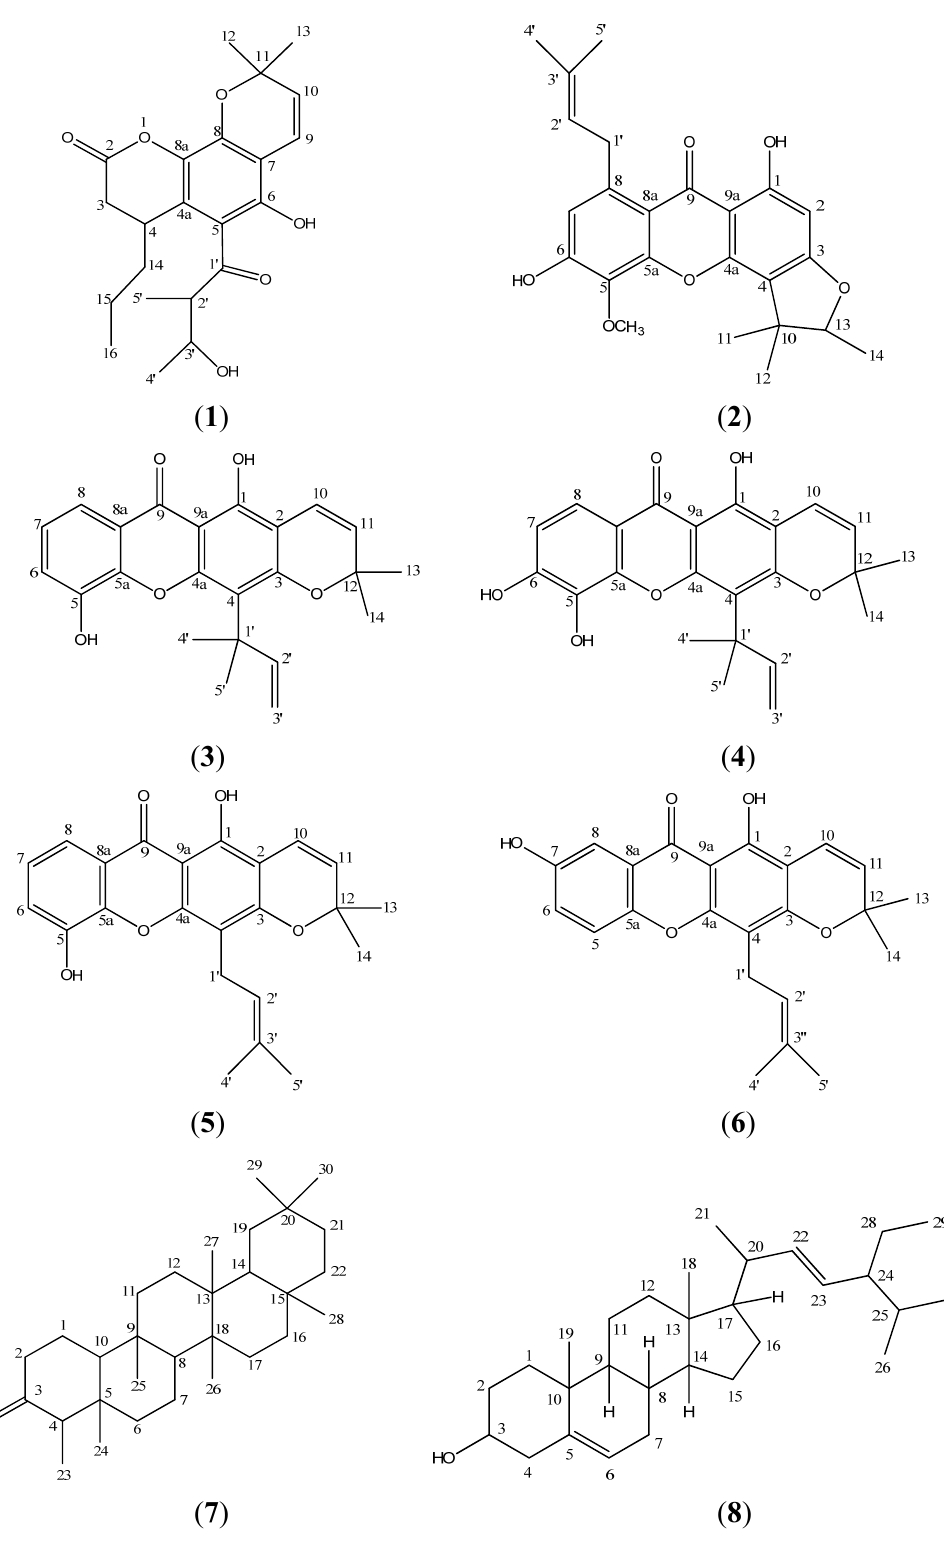
Figure 3. Structures of soulamarin ( 1 ), caloxanthone B ( 2 ), caloxanthone C ( 3 ), macluraxanthone ( 4 ), trapezifolixanthone ( 5 ), brasixanthone B ( 6 ), friedelin ( 7 ) and stigmasterol ( 8